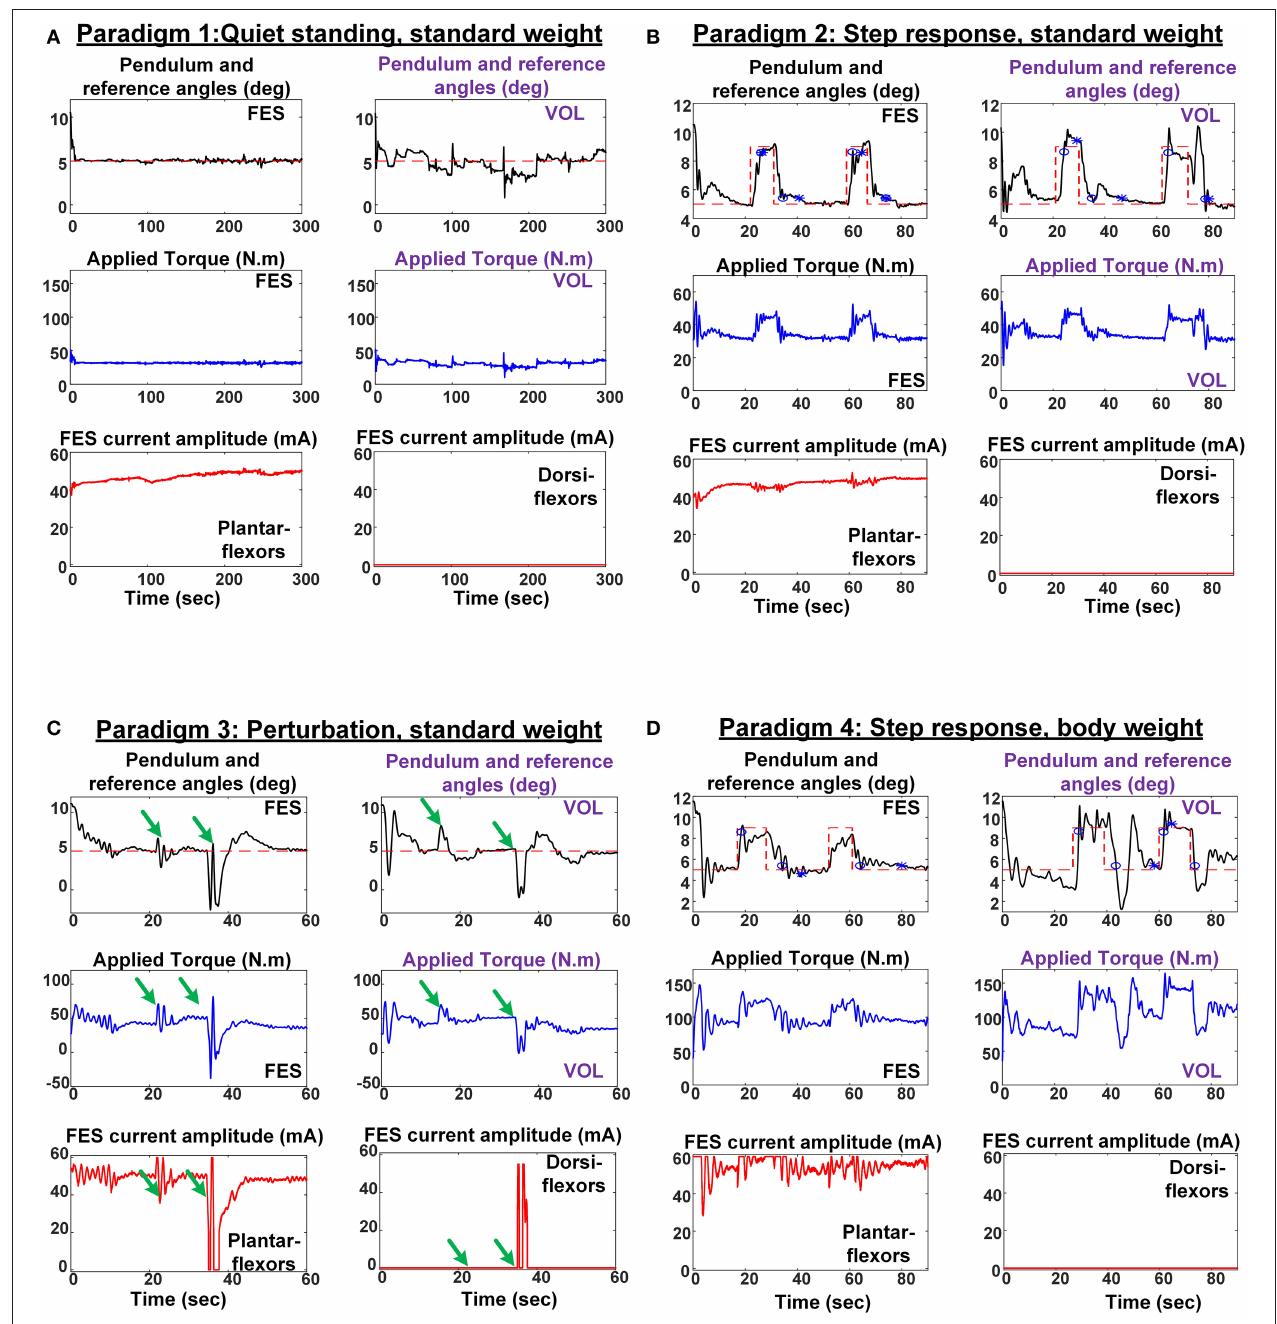
FIGURE 5 | Results for the four experimental paradigms: The inverted pendulum (black) and reference (red dashed) angles and applied torque (blue) are presented for FES control (black titles) and voluntary control (purple titles) conditions. In addition, FES pulse amplitude applied to plantarflexors and dorsiflexors in FES control condition are presented. Results are presented for a representative subject in Test paradigm (i), Quiet standing, Standard weight (A) ; Test paradigm (ii), Step response, Standard weight (B) ; Test paradigm (iii), Perturbation response, Standard weight (C) (In this figure, the instants of perturbation application are shown by green